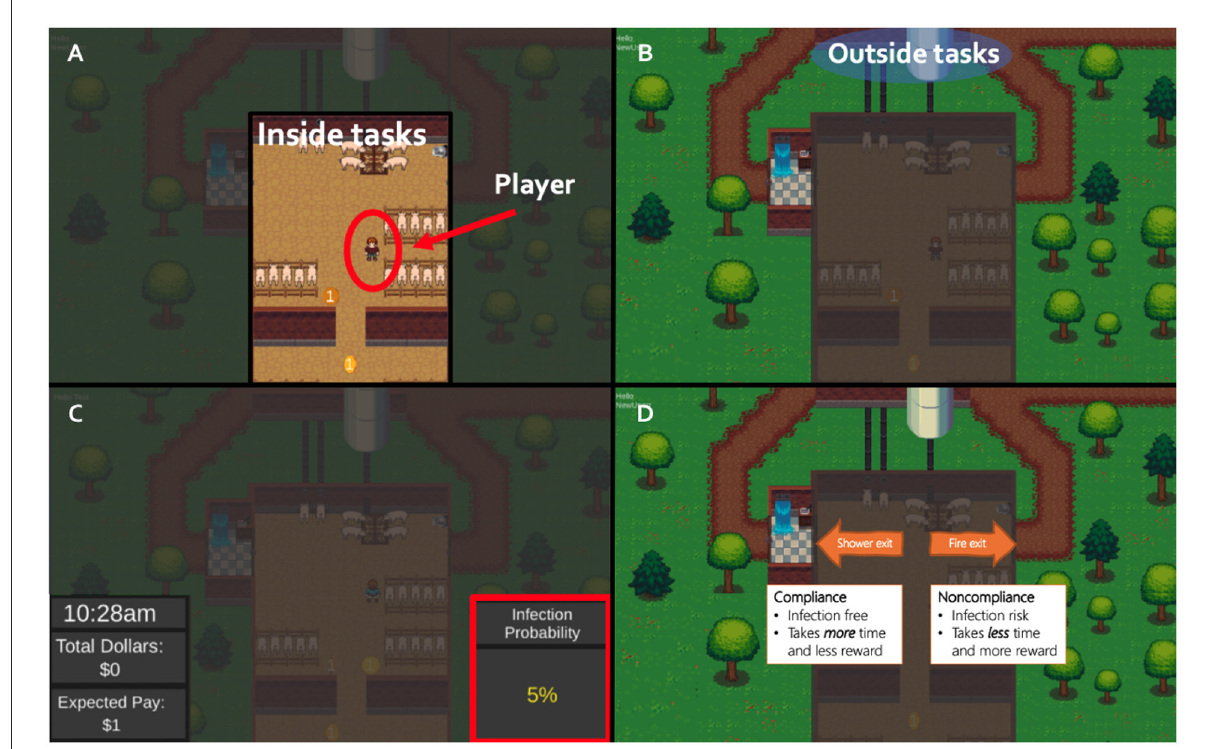
FIGURE2 The compliance game and the decision mechanism. (A) A player in the inside task area. (B) A blue circle indicates the outside task area. (C) To go from one area to another, participants have to decide to follow the shower biosecurity practice (left arrow) or break the biosecurity practice to use the emergency exit (right arrow) using the risk information. (D) Using the shower exit takes more time and has a lower monetary return than the emergency exit, but it guarantees no infection will occur at the given